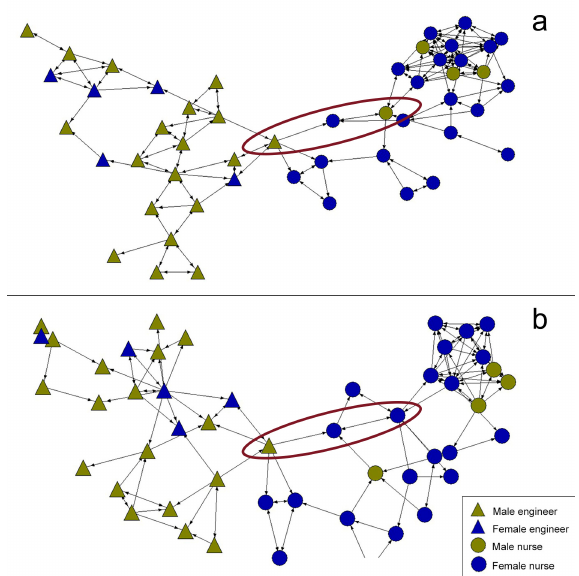
Figure 1. Pre-intervention friendship network ( a ) and collaboration network ( b ).